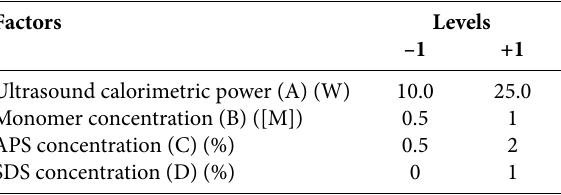
Table 4. The validity regions of the developed